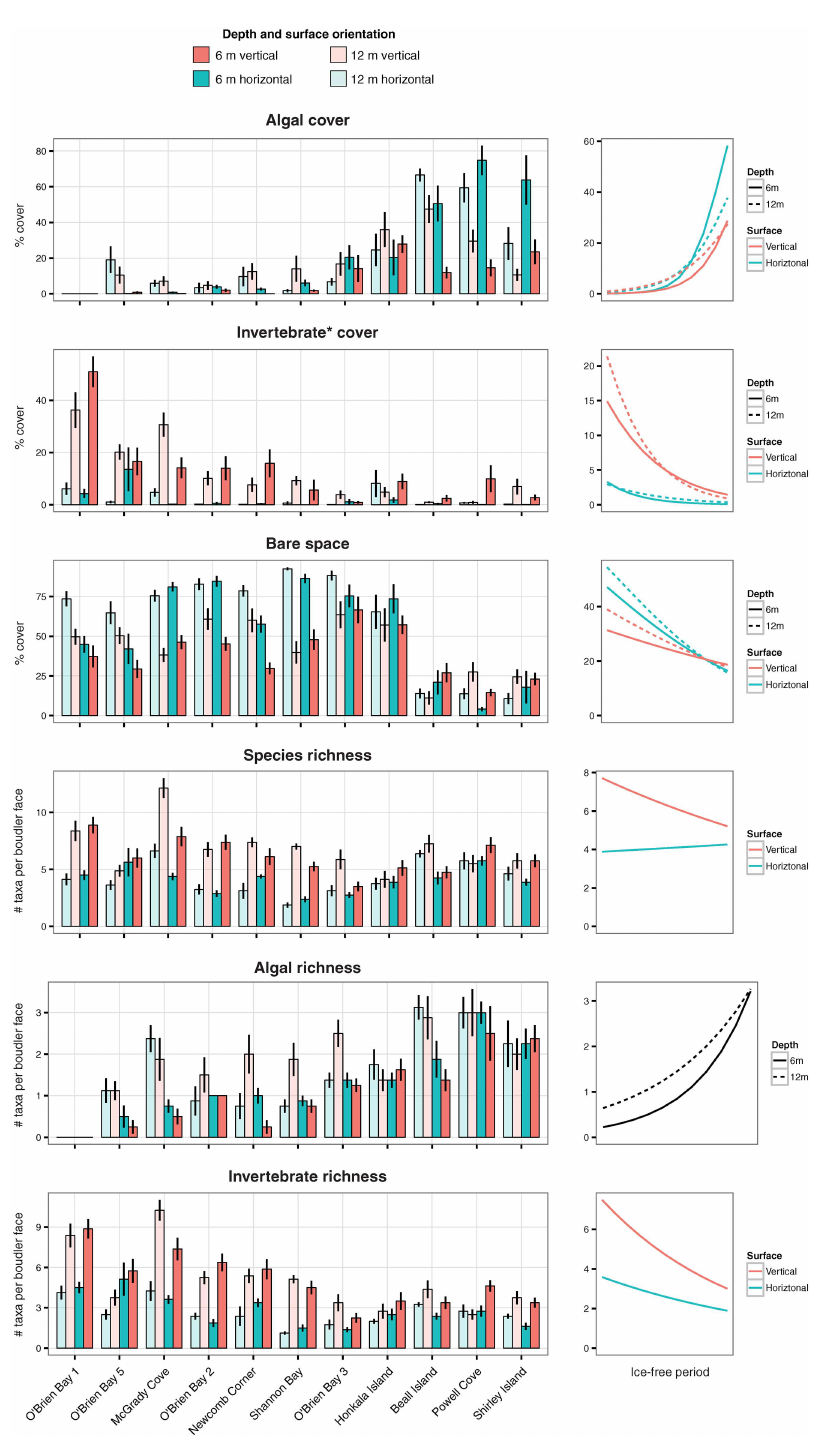
Fig 5. Percentage cover of algal, invertebrates, and bare space, and measuresof diversity. Left-hand plots show data from all sites, depths and orientations. Bars show the mean value, and error bars show standarderror. Right-hand plots show predictedvalues of significanteffects detected by